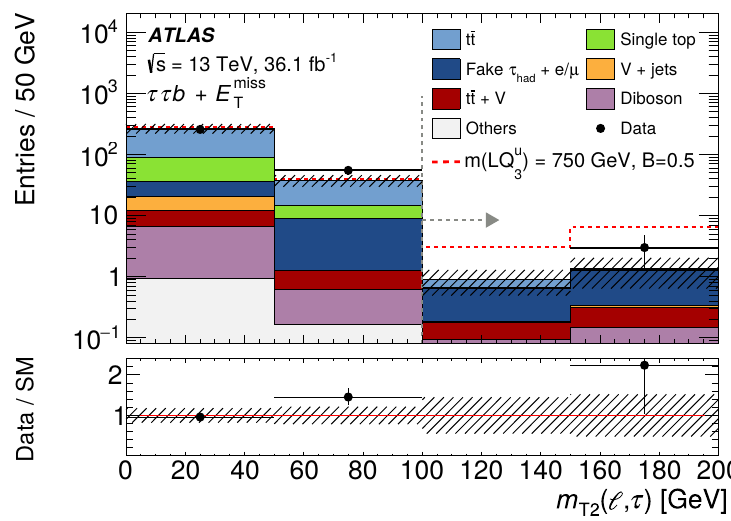
Figure 13 . Distribution of the stransverse mass m T2 ( ‘; (cid:28) had ) [46{48] in the signal region of the (cid:28) ‘ (cid:28) had channel before applying the selection requirement on m T2 ( ‘; (cid:28) had ), which is indicated by the dashed vertical line and arrow. The stacked histograms show the various SM background contributions, which are normalized to the values determined in the (cid:12)t. The hatched band indicates the total statistical and systematic uncertainty in the SM background. The error bars on the black data points represent the statistical uncertainty in the data yields. The dashed histogram shows the expected additional yields from a leptoquark signal model LQ u with m LQ = 750 GeV and B = 0 : 5 3 added on top of the SM prediction. The rightmost bin includes the over(cid:13)ow.